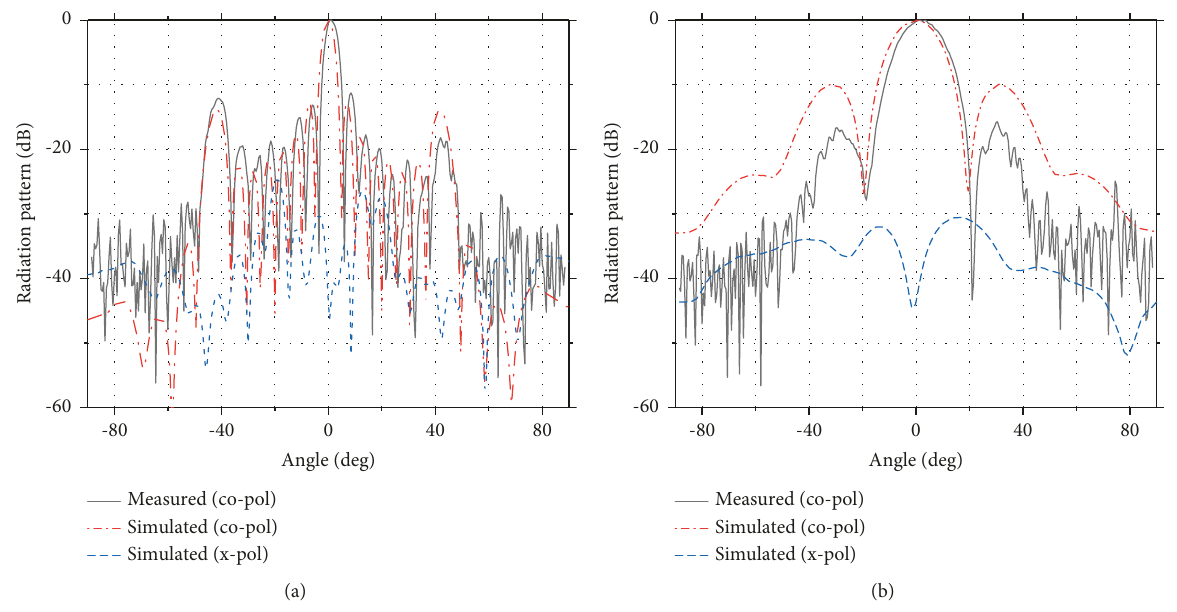
Figure 11: A comparison between the measured and simulated radiation patterns of the 2 plane.